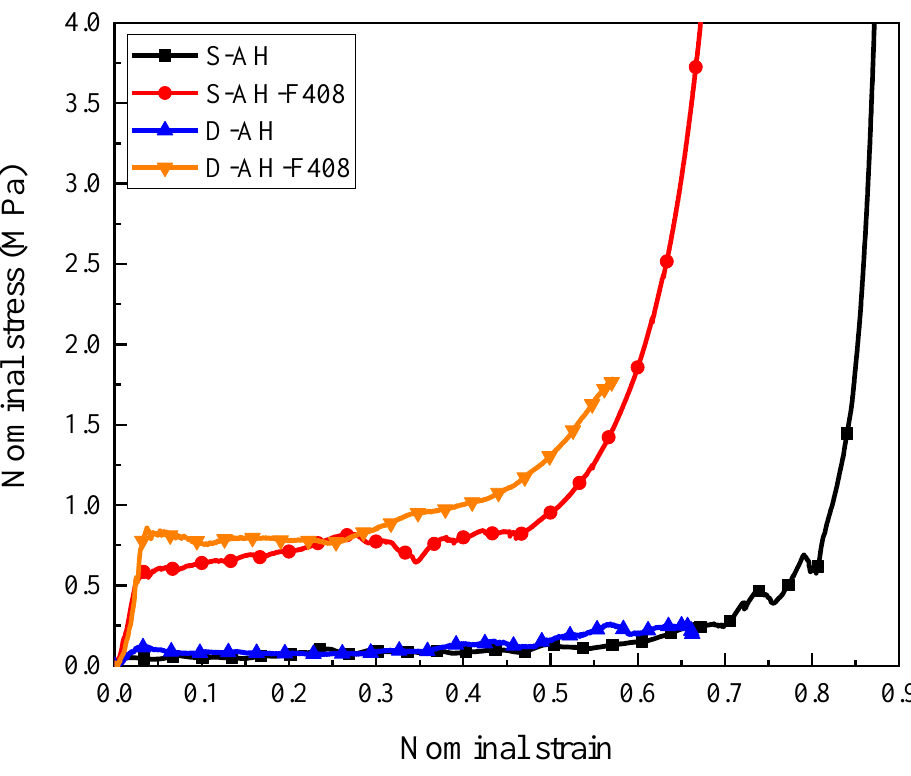
Figure 3. The stress–strain relationships of the specimens with different loading rates. The thickness of the honeycombs was 0.25 mm, for both the hollow and filled specimens. D in the sample index indicates the quasi-static and dynamic tests, respectively. AH represents auxetic honeycomb while F means foam concrete. For instance, D-AH-F408 represents the auxetic honeycomb filled with 408 kg/m 3 foam concrete subjected to dynamic compression with 1 m/s.